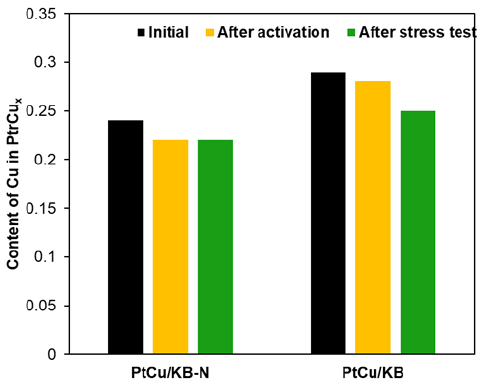
Figure 6. Compositions of the metal component in the bimetallic catalysts in the “as-prepared” state, after the electrochemical activation, and after the stress test.